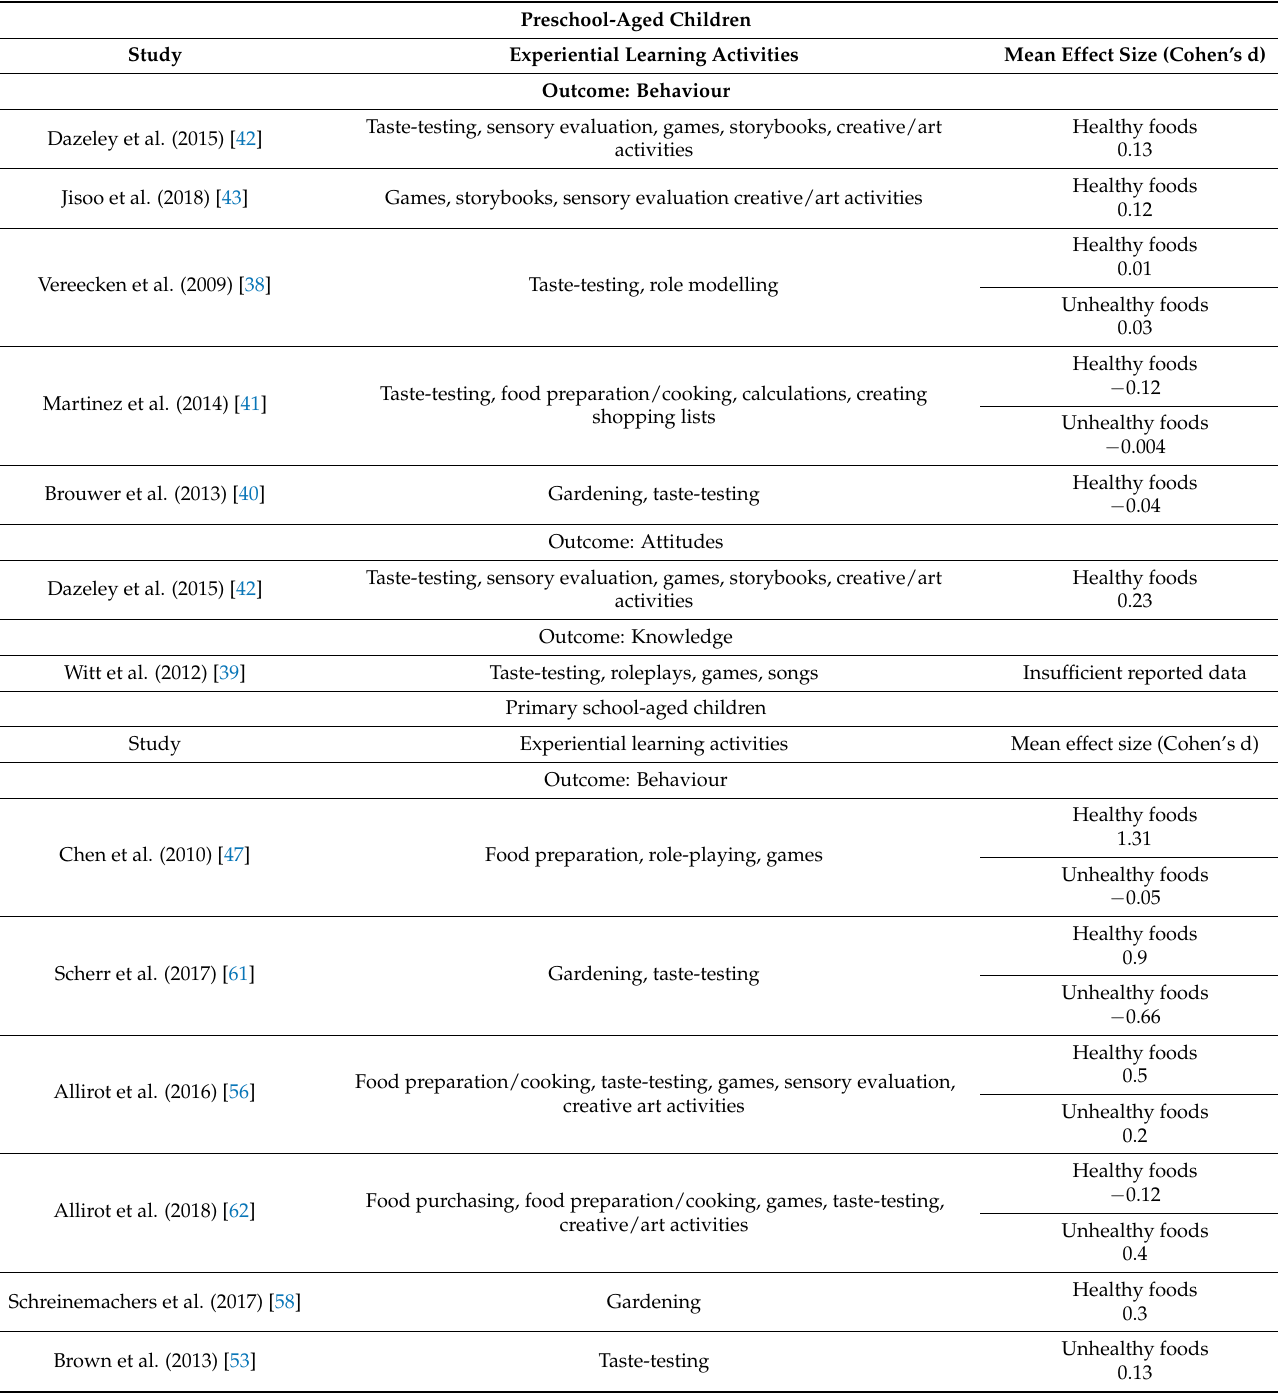
Table 3. Experiential learning activities and effect sizes on outcomes (Healthy foods and unhealthy